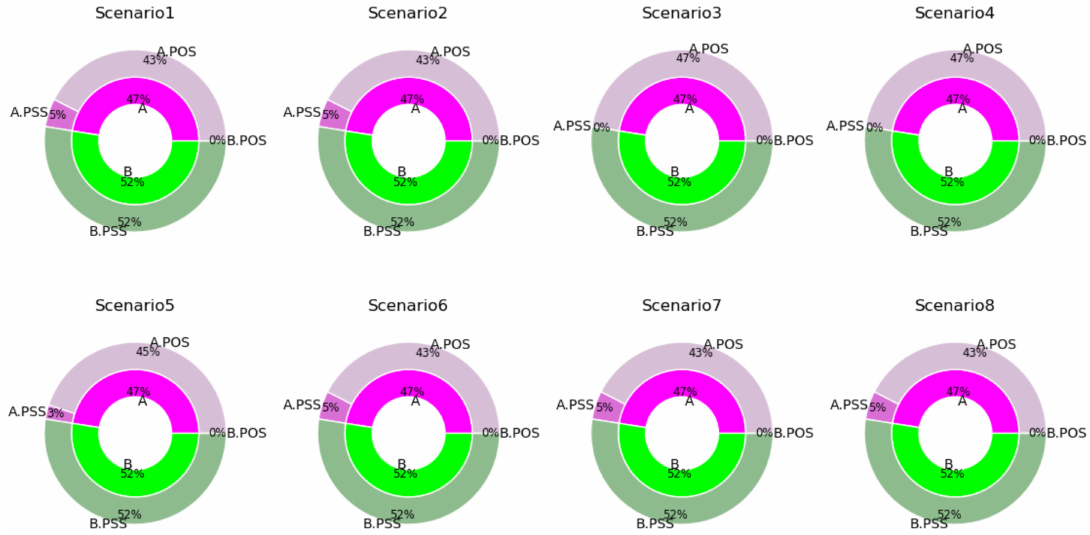
Figure 10. Market Share for All Scenarios6.1. Customer’s Economic